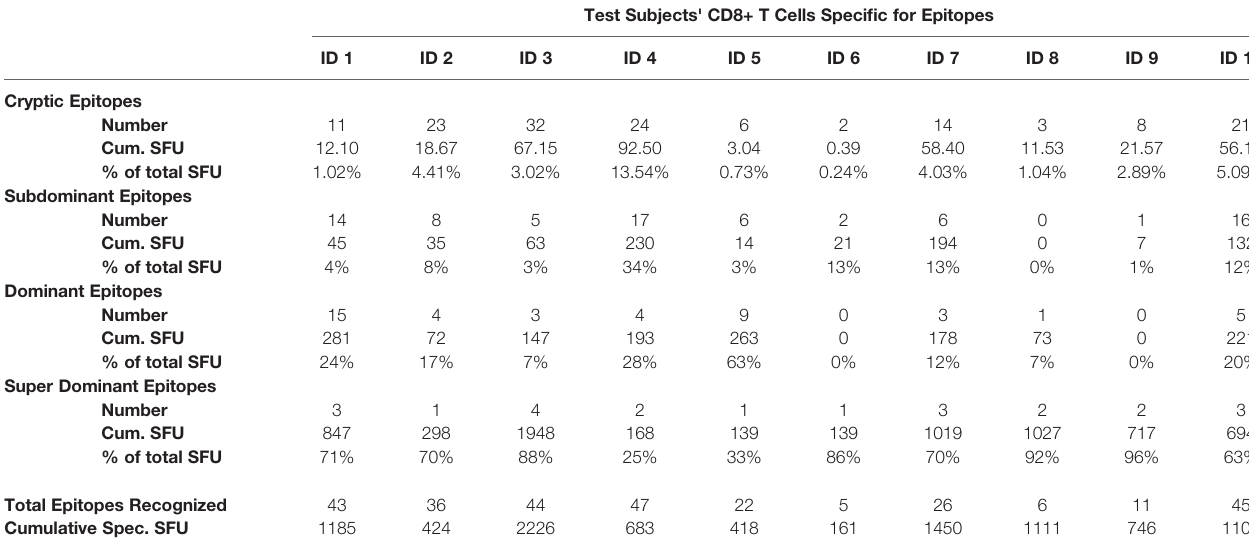
TABLE 2 | HCMV ppp65 epitope category distribution in HCMV positive, HLA-A*02:01 positive